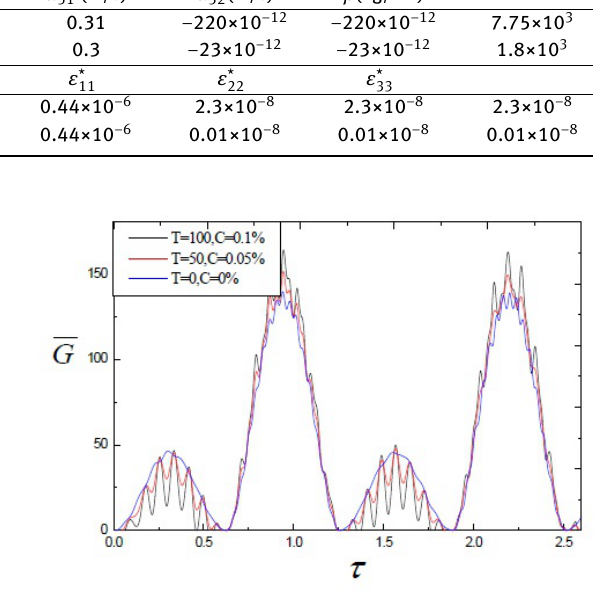
Fig. 5. Effect of temperature and humidity on energy release rate of delaminated piezoelectric